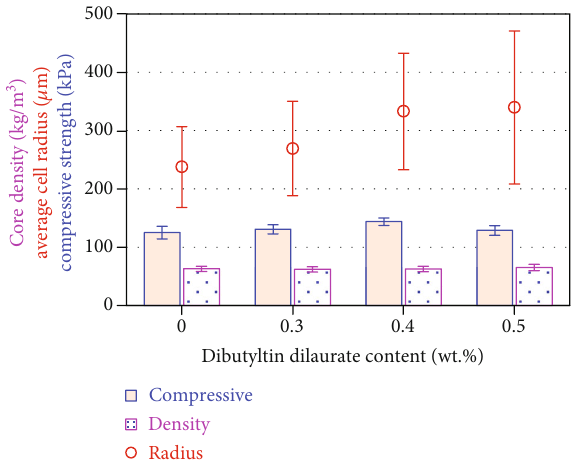
Figure 1: Dependence of properties of rigid PU foams on dibutyltin dilaurate content.